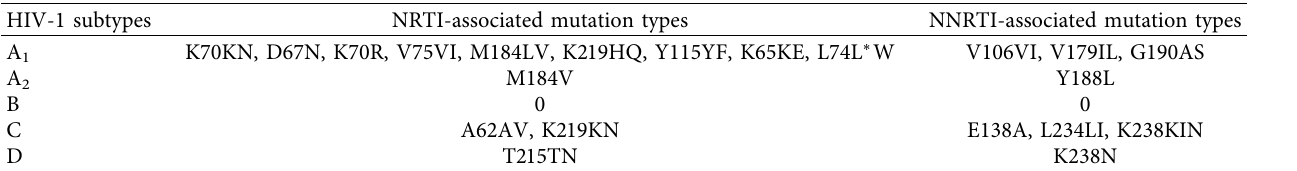
Table 5: HIV-1 subtypes and the associated mutations among drug-naive IDUs.